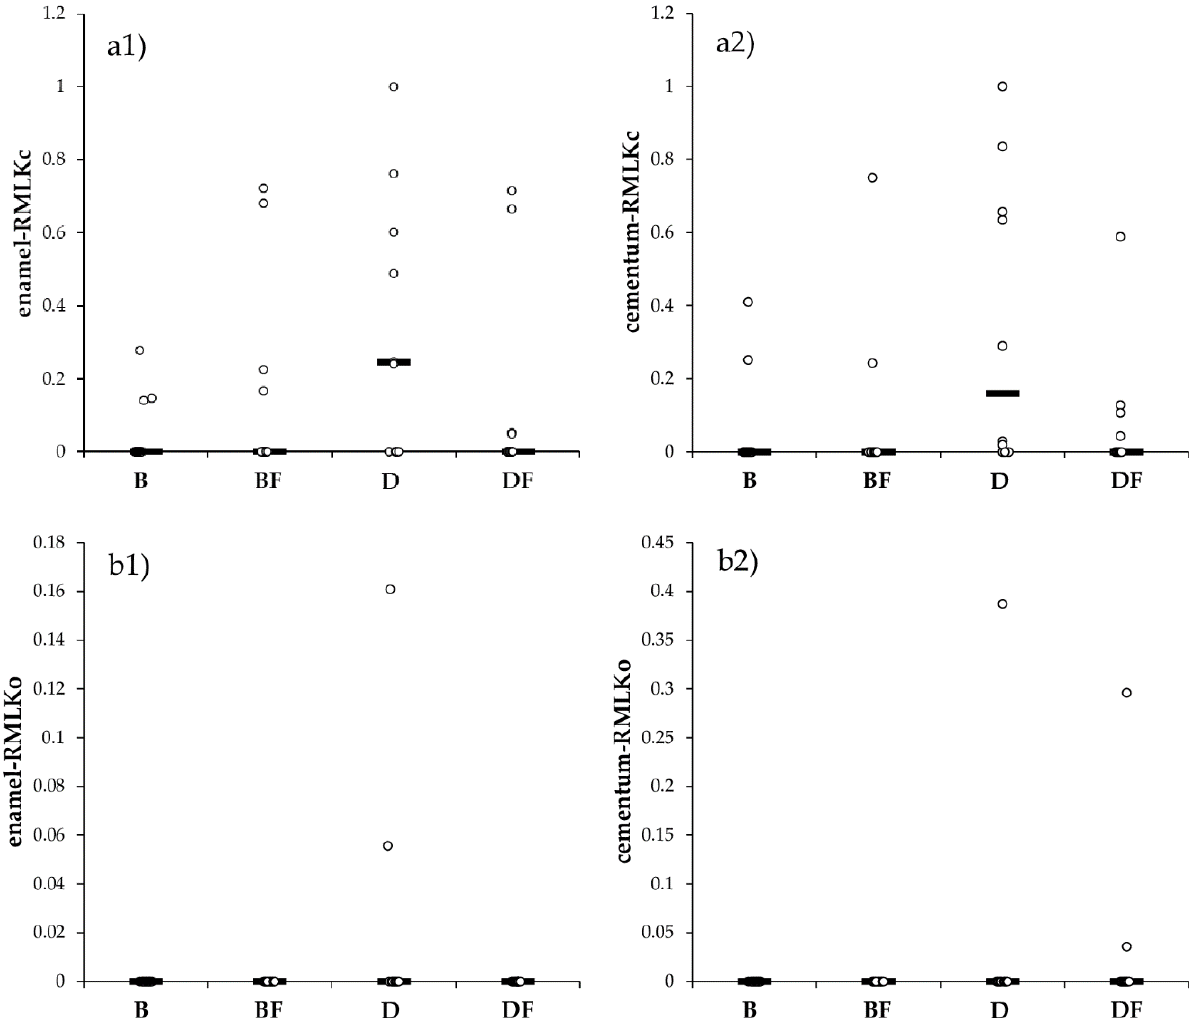
Figure 2. Variability of RMLK by type of restoration and material: RMLKc for restorations located in enamel ( a1 ) and cementum ( a2 ). RMLKo for restorations located in enamel ( b1 ) and cementum ( b2 ). RMLK = ratio of marginal microleakage; RMLKc = cervical RMLK; RMLKo = occlusal RMLK; B = Beautiful II LS ® ; BF = Beautiful Flow Plus ® ; D = Dynamic Plus ® ; DF = Dynamic Flow ® .